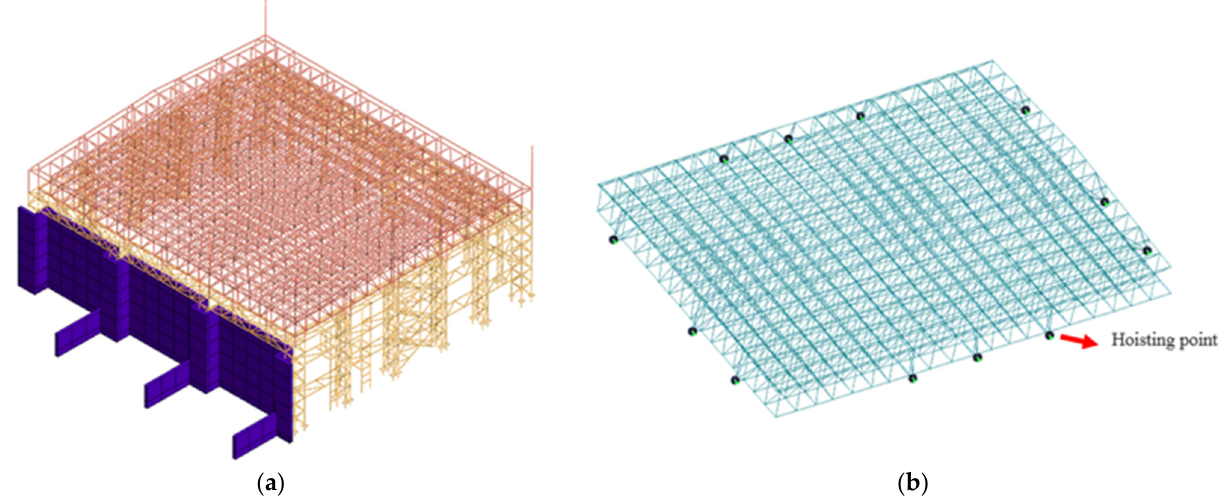
Figure 12. Numerical model: ( a ) converter station steel structure and ( b ) hoisting point.